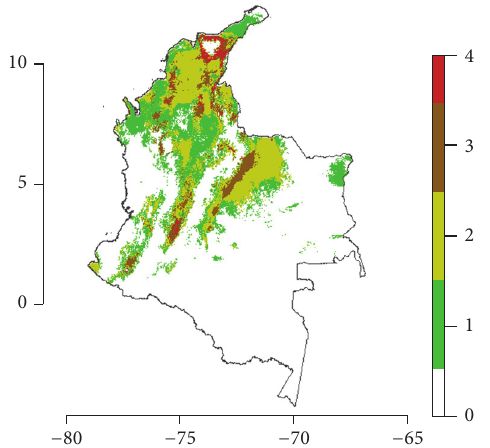
Figure 5: Combined diversity map for Triatominae species in Colombia. The color scale shows the following: white, zero species; green,onespecies;lightgreen,twospecies;brown,threespecies;and red, four